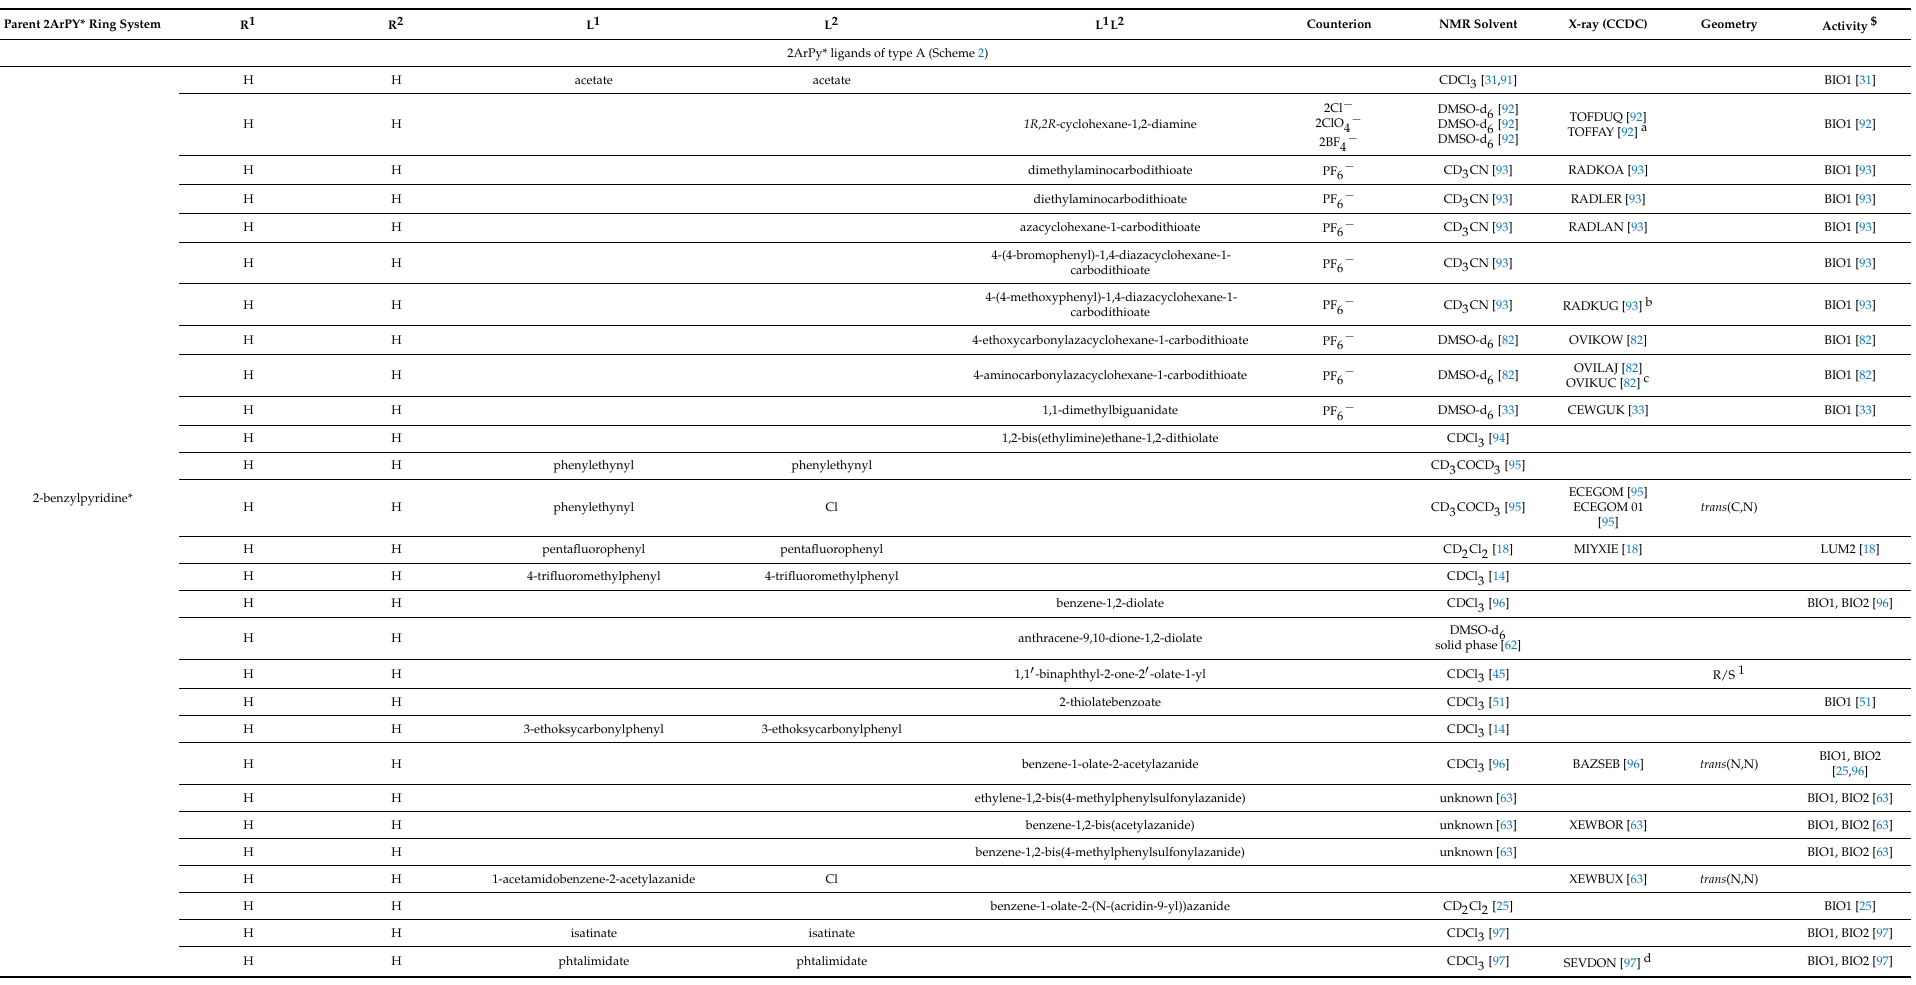
Table 5. NMR and/or X-ray studied [Au(2ArPY*)L 1 L 2 ] (in particular, [Au(2ArPY*)L 2 ]) or [Au(2ArPY*)(L 1 L 2 )]) (in particular, [Au(2ArPY*)(LL)])